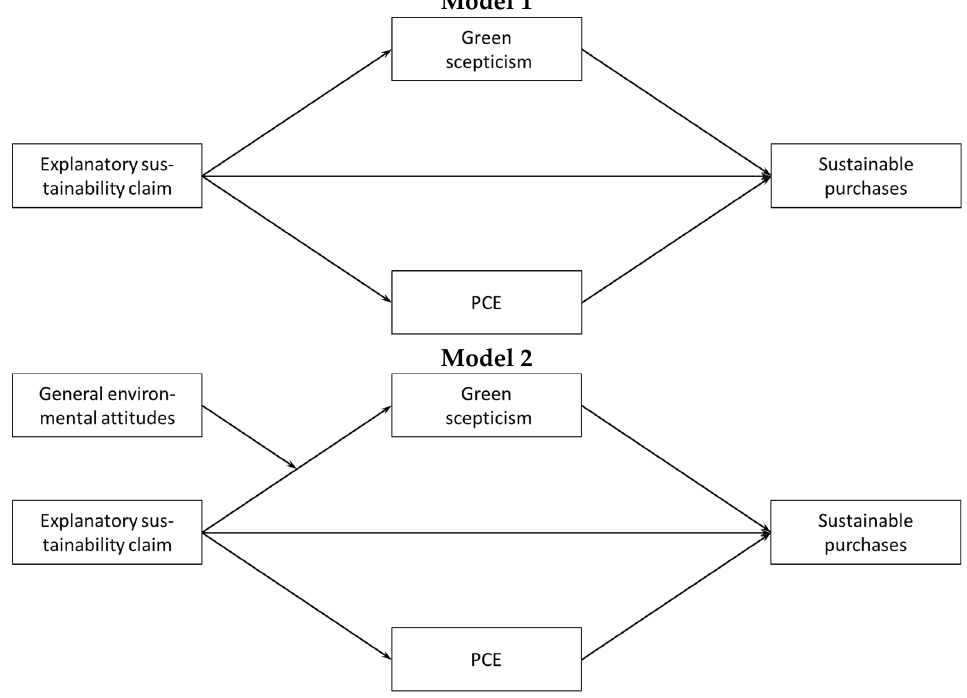
Figure 1. Baseline path models. Note: In these models, the two explanatory sustainability claims (with and without the health claim condition) are merged. In Model 1, general environmental attitudes are added as a control variable.